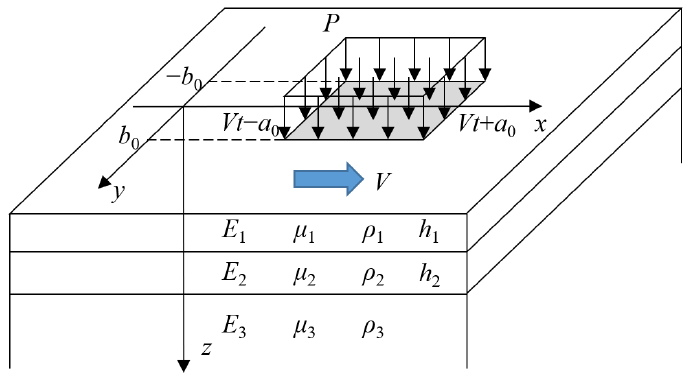
Figure 1. Viscoelastic three-layered system under a rectangular uniform moving load.